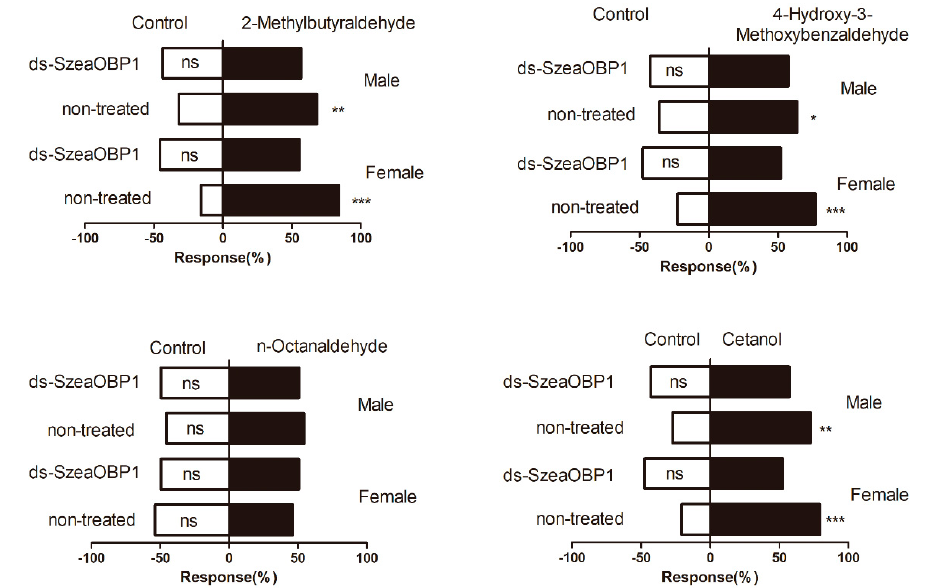
Figure 10. Behavioral responses of Sitophilus zeamais to four selected volatiles in a Y-tube olfactometer after dsRNA treatment. Activity is expressed as percentage weevils responding, and bars followed by di ff erent marker indicate significantly di ff erent activity of the weevils between the treatments ( p < 0.05). The mean values shown are predicted values from regression analysis. ‘*’ indicates significant differences from even distribution at * p < 0.05, or ** p < 0.01, *** p < 0.001. ‘ns’ indicates not significantly different.